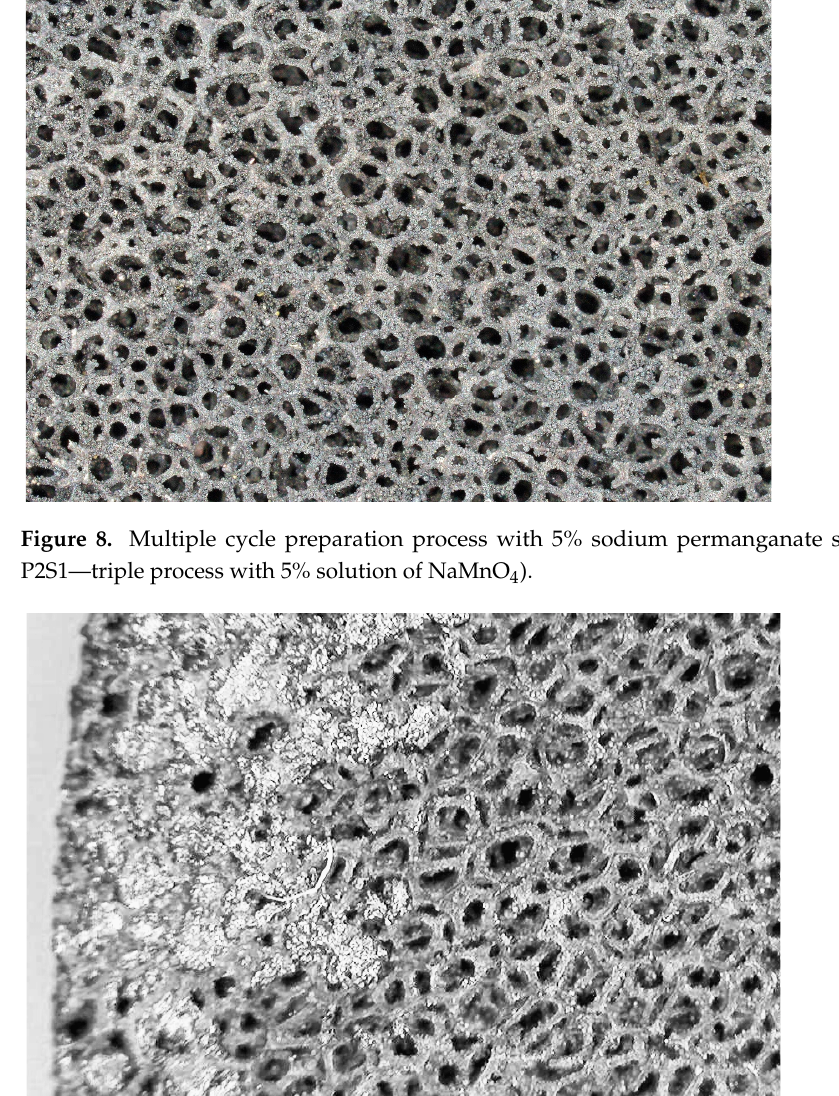
Figure 4. Impregnation with 5% water solution of potassium permanganate (sample P3S1). Figure 9. Impregnation with 5% water solution of potassium permanganate (sample